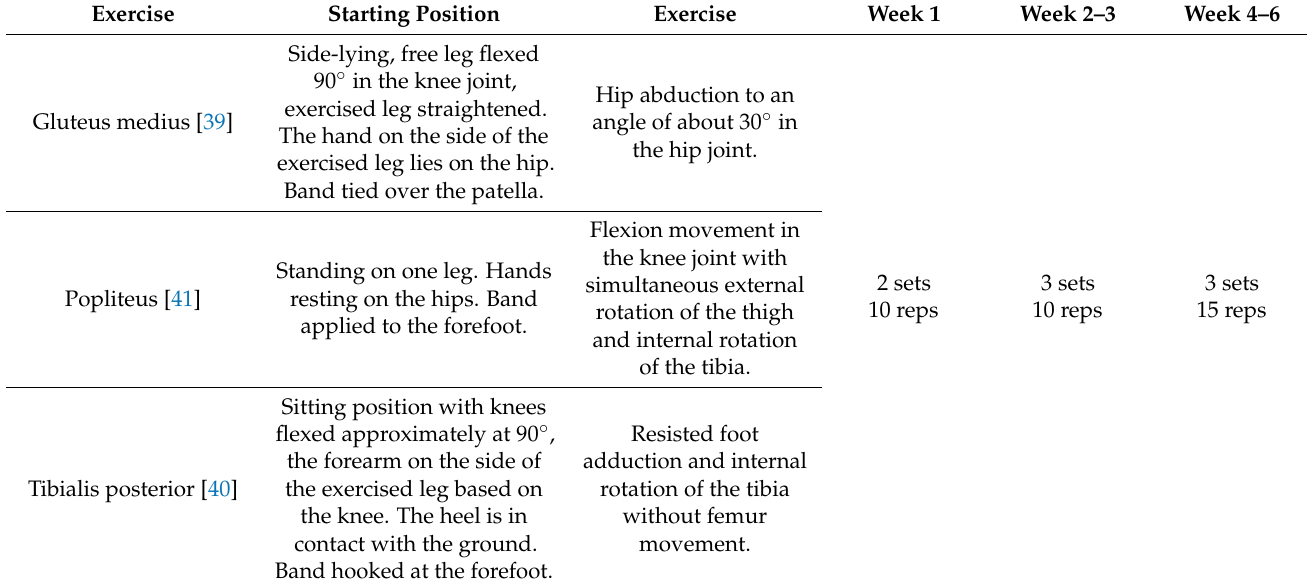
Table 1. Exercises